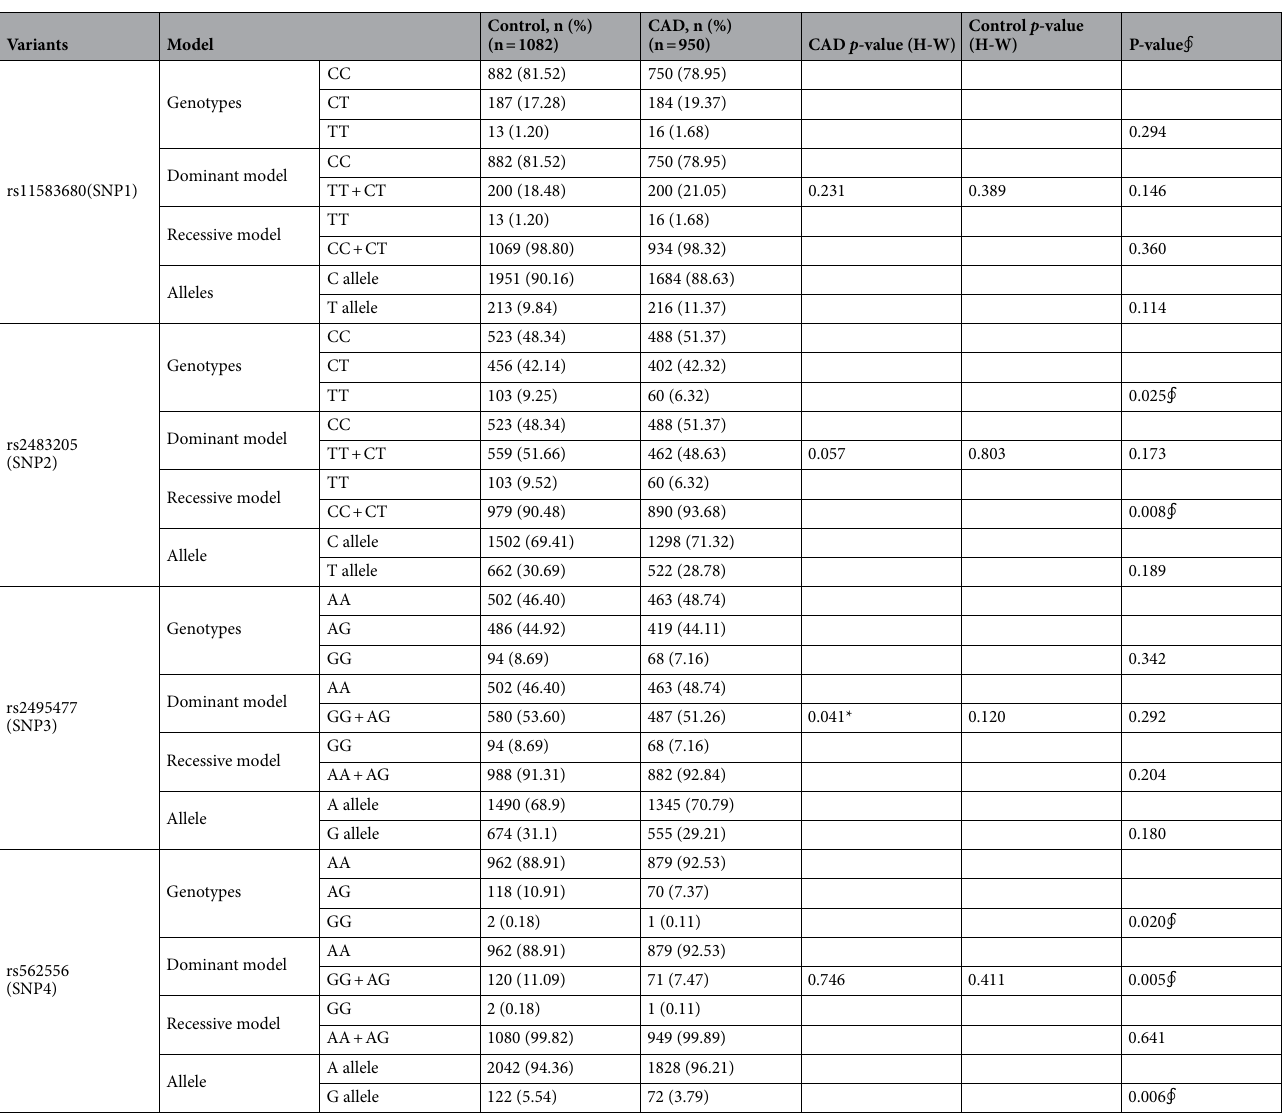
Table 2. Genotype and allele distributions in control subjects and CAD patients. CAD coronary artery disease. * p values < 0.05 for Hardy–Weinberg equilibrium in CAD patients and controls. ∮ p values < 0.05 for distribution frequency for genotypes and alleles of the 4 SNPs in the PCSK9 gene.